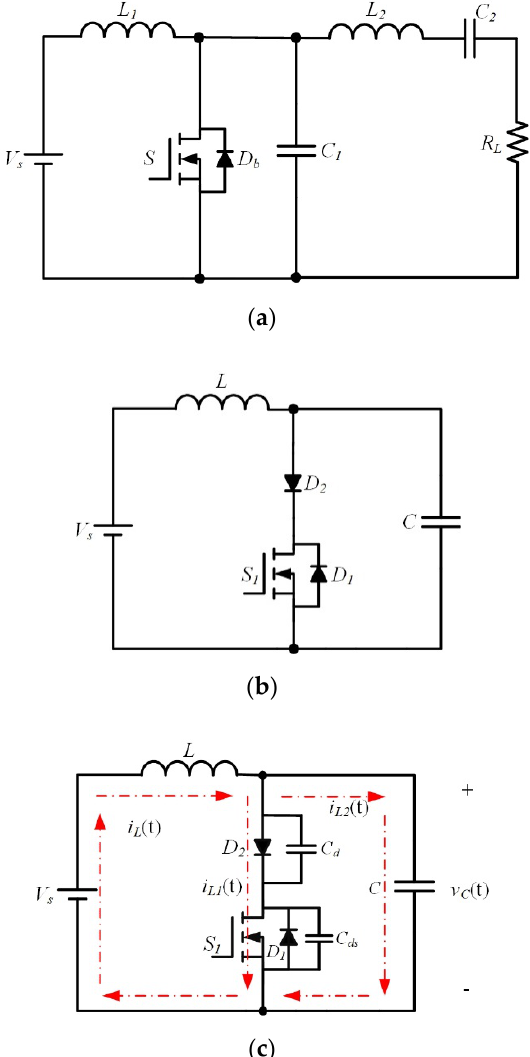
Figure 2. The main circuit evolution of the sinusoidal load: ( a ) the original class E topology; ( b ) the equivalent circuit; and ( c ) the equivalent circuit with a parasitic capacitance model.